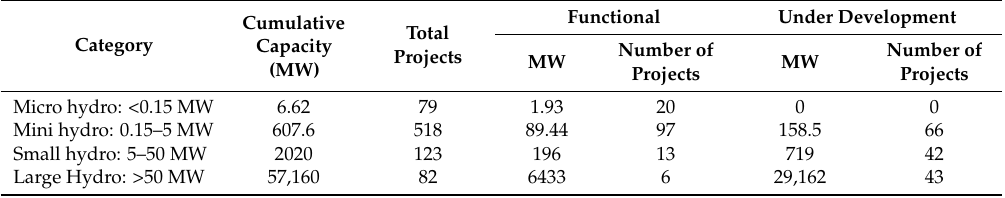
Table 3. Pakistan’s hydropower portfolio. MW: megawatt.